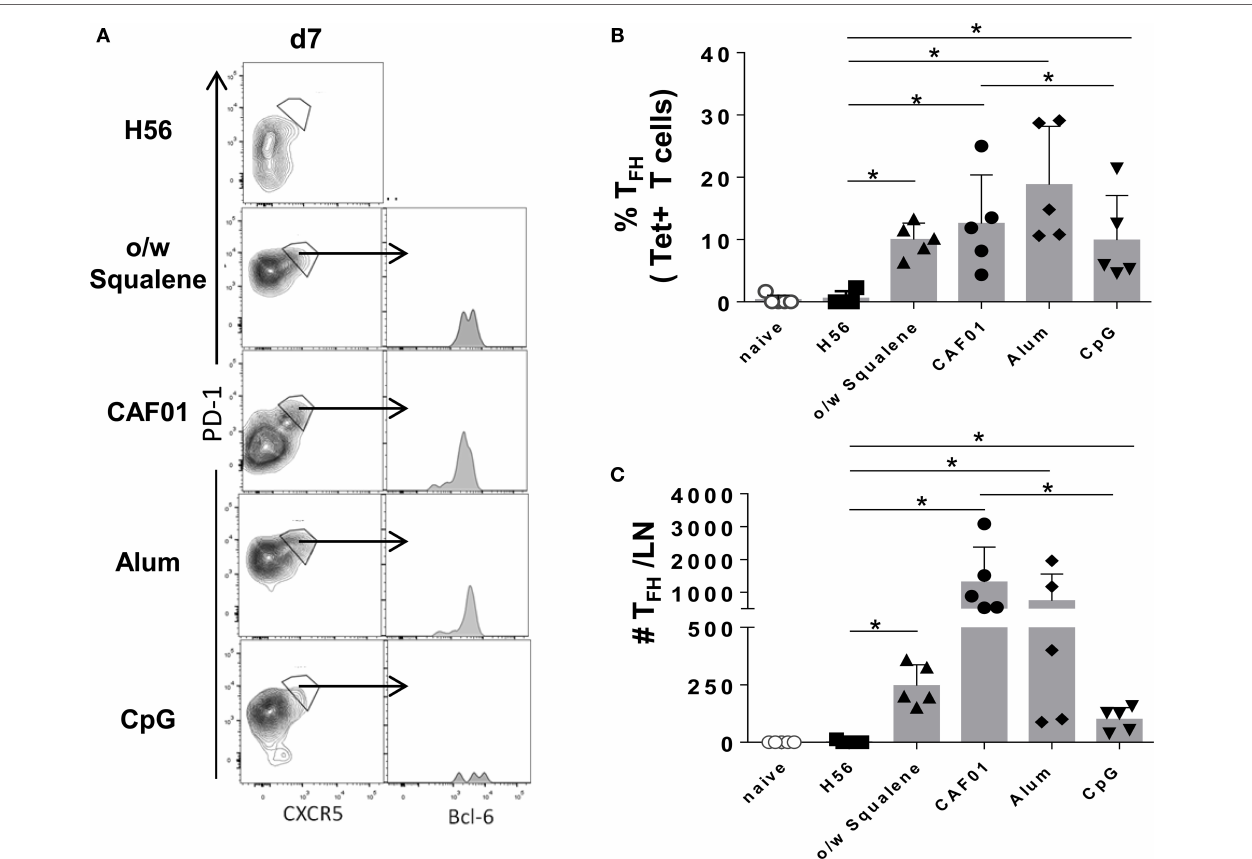
FigUre 6 | Tfh cells induction . Mice were subcutaneously immunized with H56 alone (H56) or combined with different adjuvants (o/w squalene, CAF01, alum, and CpG), and draining lymph nodes were collected 7 days after immunization. (a) Analysis of the expression of CXCR5 and PD-1 among tetramer-binding CD4 + T cells, for identifying Tfh cells. The intracellular expression of Bcl-6, within CXCR5 + PD-1 + cells, is reported as histogram. Data are shown from a single animal representative of the group. (B,c) Frequencies of Tfh cells, with respect to tetramer + CD4 + T cells (B) and absolute numbers of Tfh cells per dLN (c) , elicited by different vaccine formulations reported as mean ± SD of five mice per group; data are representative of two independent experiments. Mann–Whitney test, with Bonferroni correction for multiple pairwise comparisons, was used for assessing the statistical difference between each group immunized with adjuvant and the H56-immunized group. Kruskal–Wallis test, followed by Dunn’s post test for multiple comparisons, was used to assess the statistical difference between groups immunized with different adjuvants (* P ≤